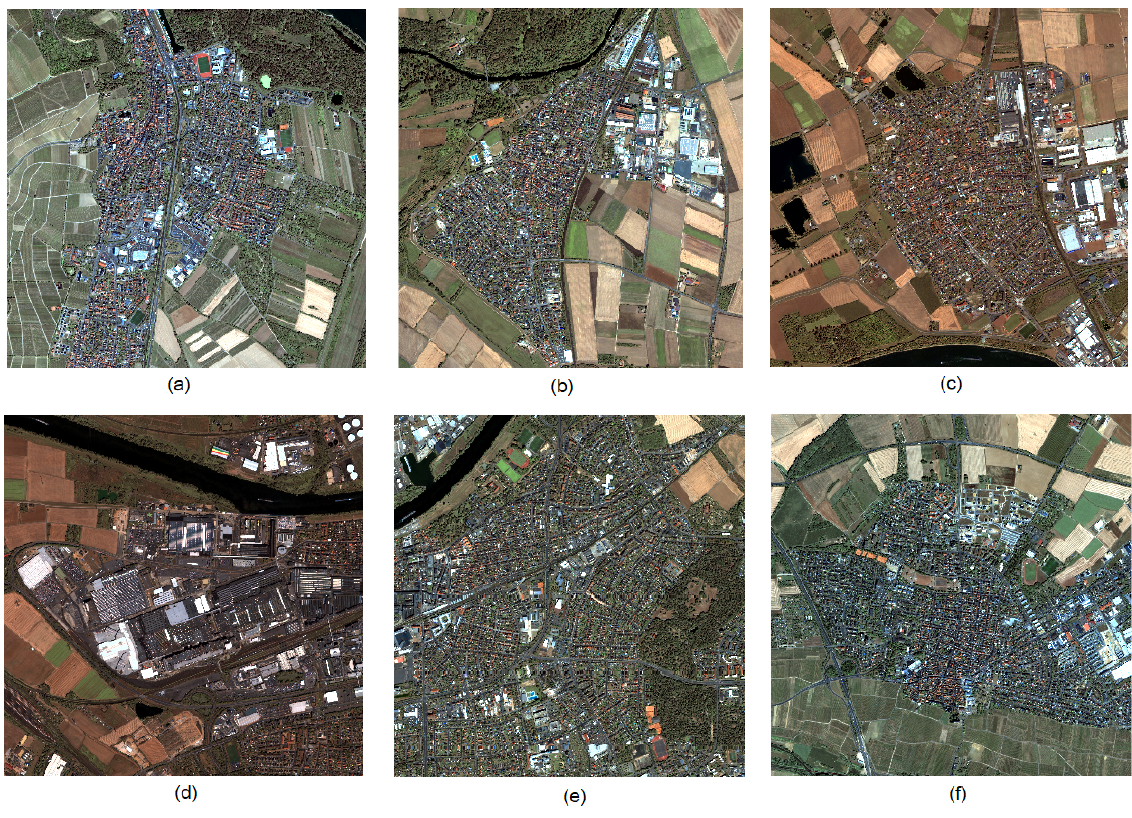
Figure 1. Pansharpened images of the 6 selected test regions, each 4000 × 4000 m 2